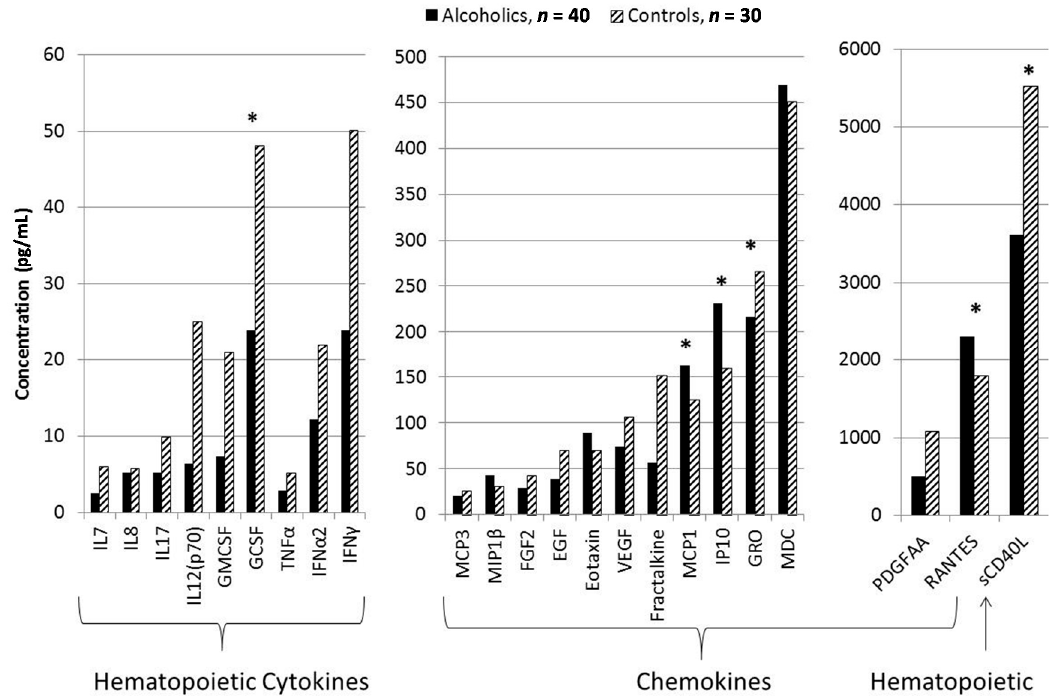
Figure 1. Histograms representing plasma cytokine levels for n = 40 adult male African-American alcoholic and n = 30 control participants with statistical analyses for each of the 23 detectable cytokines meeting the laboratory requirements for inclusion grouped by alcoholism diagnosis. Significance values are indicated: * p < 0.05 based upon generalized linear model with Bonferroni correction. Standard deviations for the alcoholism group IL7 = 2.8; IL8 = 6.3; IL17 = 10; IL12(p70) = 17; GMCSF = 19; GCSF = 12; TNF α = 4.2; interferon α 2a = 12; MCP3 = 27; MIP1 β = 26; FGF2 = 37; EGF = 38; eotaxin = 60; VEGF = 90; fractalkine = 186; MCP1 = 63; IP-10 (interferon γ -induced protein-10) = 365; GRO = 98; macrophage-derived chemokine (MDC) = 135; PDGFAA = 305; RANTES = 1039; soluble CD40 ligand (sCD40L) = 2933. Standard deviations for the control group IL7 = 18; IL8 = 16; IL17 = 30; IL12(p70) = 58; GMCSF = 88; GCSF = 50; TNF α = 18; interferon α 2a = 51; MCP3 = 29; MIP1 β = 29; FGF2 = 70; EGF = 82; eotaxin = 23; VEGF = 159; fractalkine = 608; MCP1 = 32; IP-10 = 455; GRO = 151; MDC = 165; PDGFAA = 1362; RANTES = 629; sCD40L = 3285. Plasma Cytokine Levels in African-American Men with Alcoholism Compared with Controls.